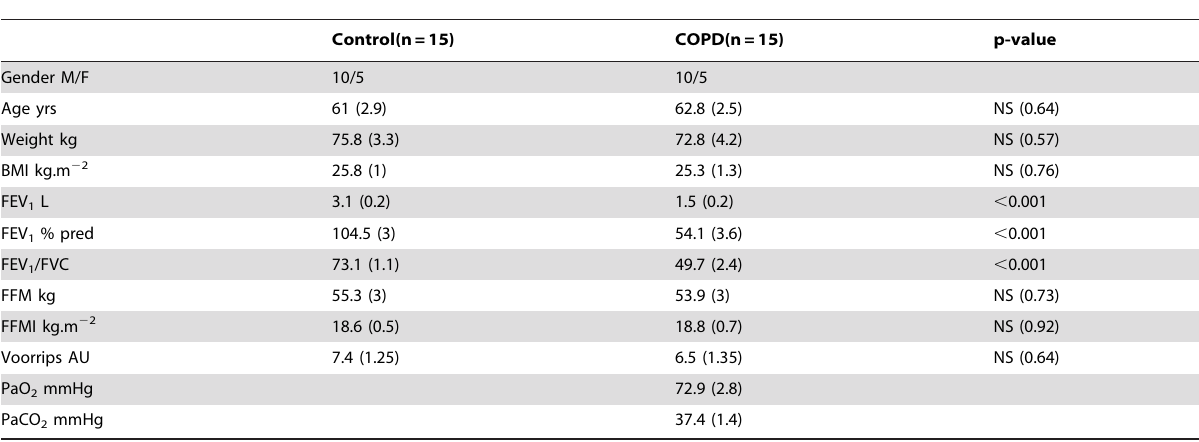
Table 1. Characteristics of the subjects included in the study.